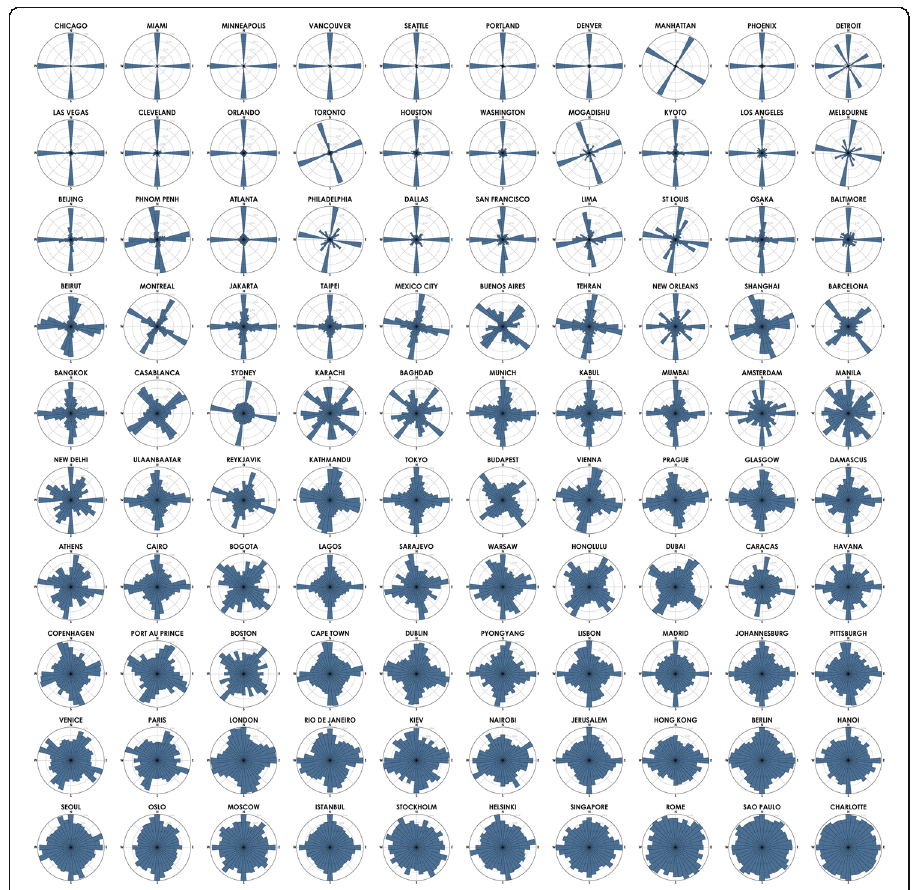
Fig. 5 Polar histograms from Fig. 4, resorted by descending φ from most to least grid-like (equivalent to least to greatest